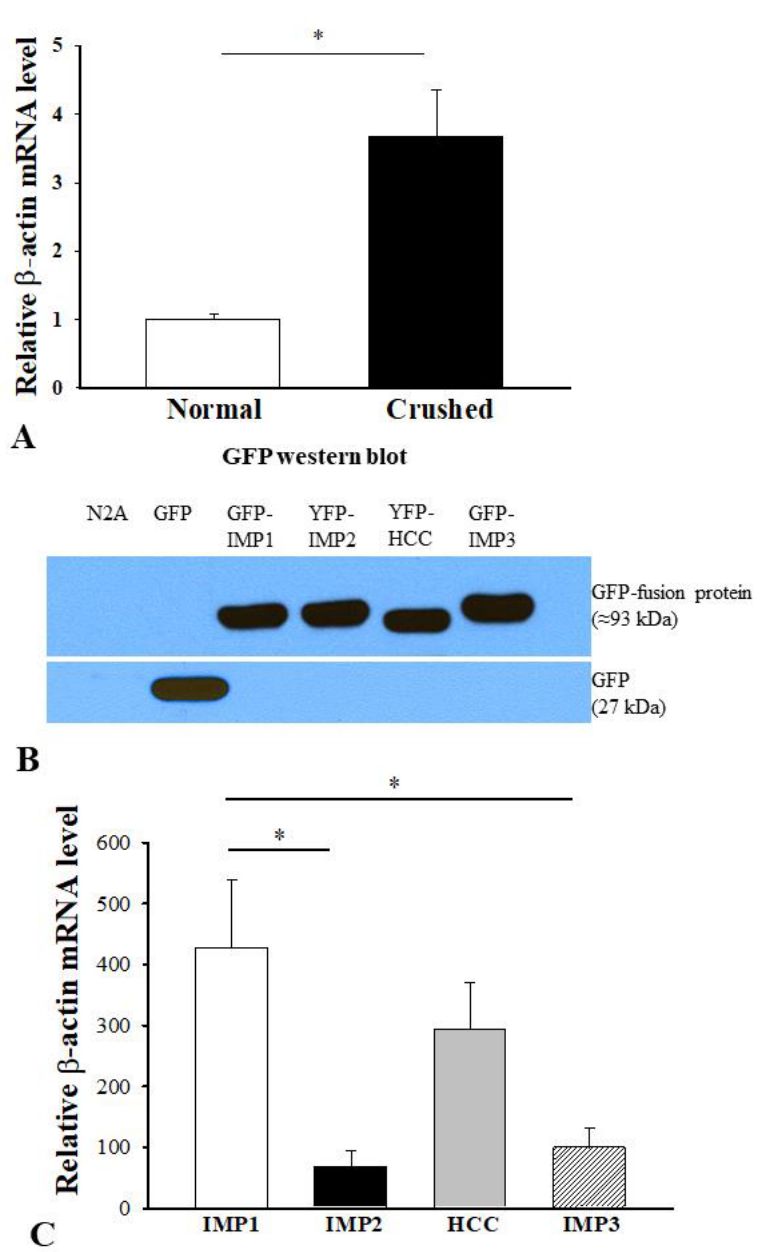
Figure 3. Relative quantification of β -actin mRNA in the crushed sciatic nerve and GFP immunoprecipitants from the N2A cells transfected with GFP-IMPs. ( A ) Comparative Ct method was used for relative quantification of β -actin mRNA. Level of β -actin mRNA in the crushed sciatic nerve is significantly higher than the sham control at 7 days post-surgery. The data are expressed as fold change mean ± s.e.m. (N = 5, * p < 0.05). ( B ) GFP Western blot confirmed transgene expression of GFP, GFP-IMP1, YFP-IMP2, YFP-HCC, and GFP-IMP3 in N2A cells. ( C ) The cell lysates were processed for immunoprecipitation with anti-GFP antibody followed by real-time PCR for β -actin mRNA. Statistical analyses of relative quantification of β -actin mRNA by one-way ANOVA with Tukey’s HSD post hoc test revealed that its levels in YFP-IMP2 and GFP-IMP3 pellets are significantly lower than that in GFP-IMP1 pellet. No statistical difference is reached when YFP-HCC is compared with YFP-IMP2 or GFP-IMP3. The data are reported as fold change mean ± s.e.m. (N = 3, * p < 0.05).